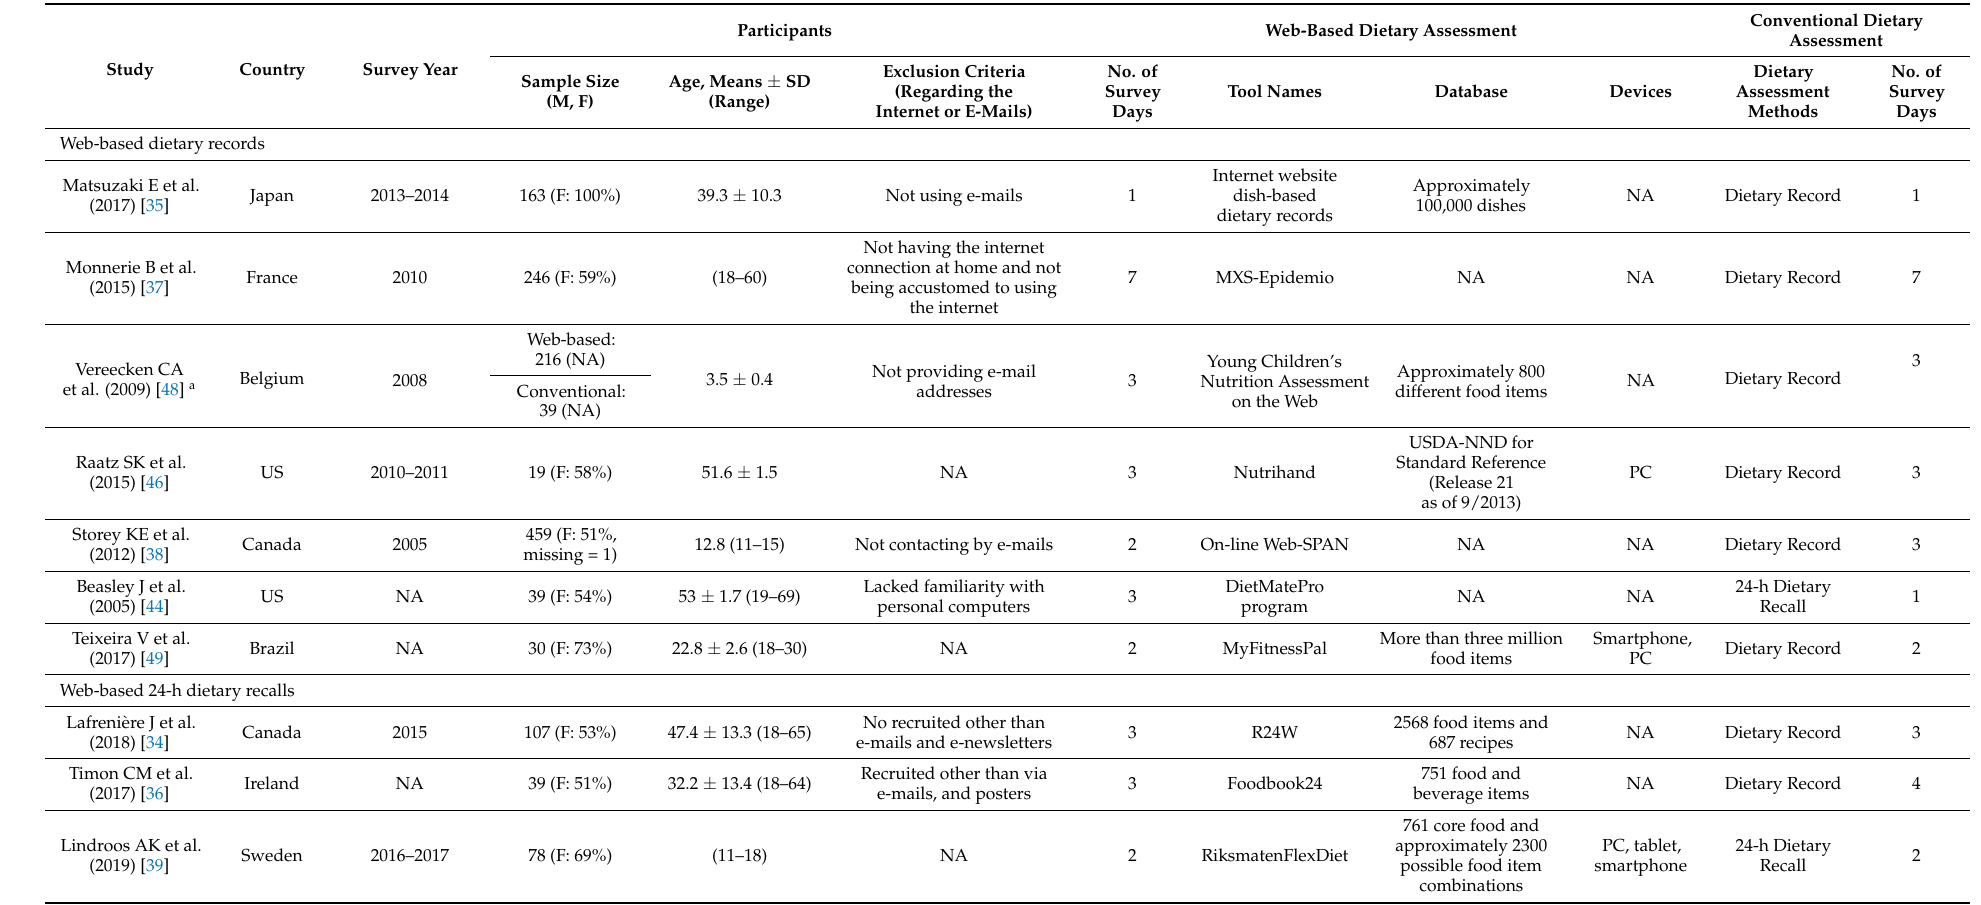
Table 1. Characteristics of the web-based dietary records or 24-h dietary